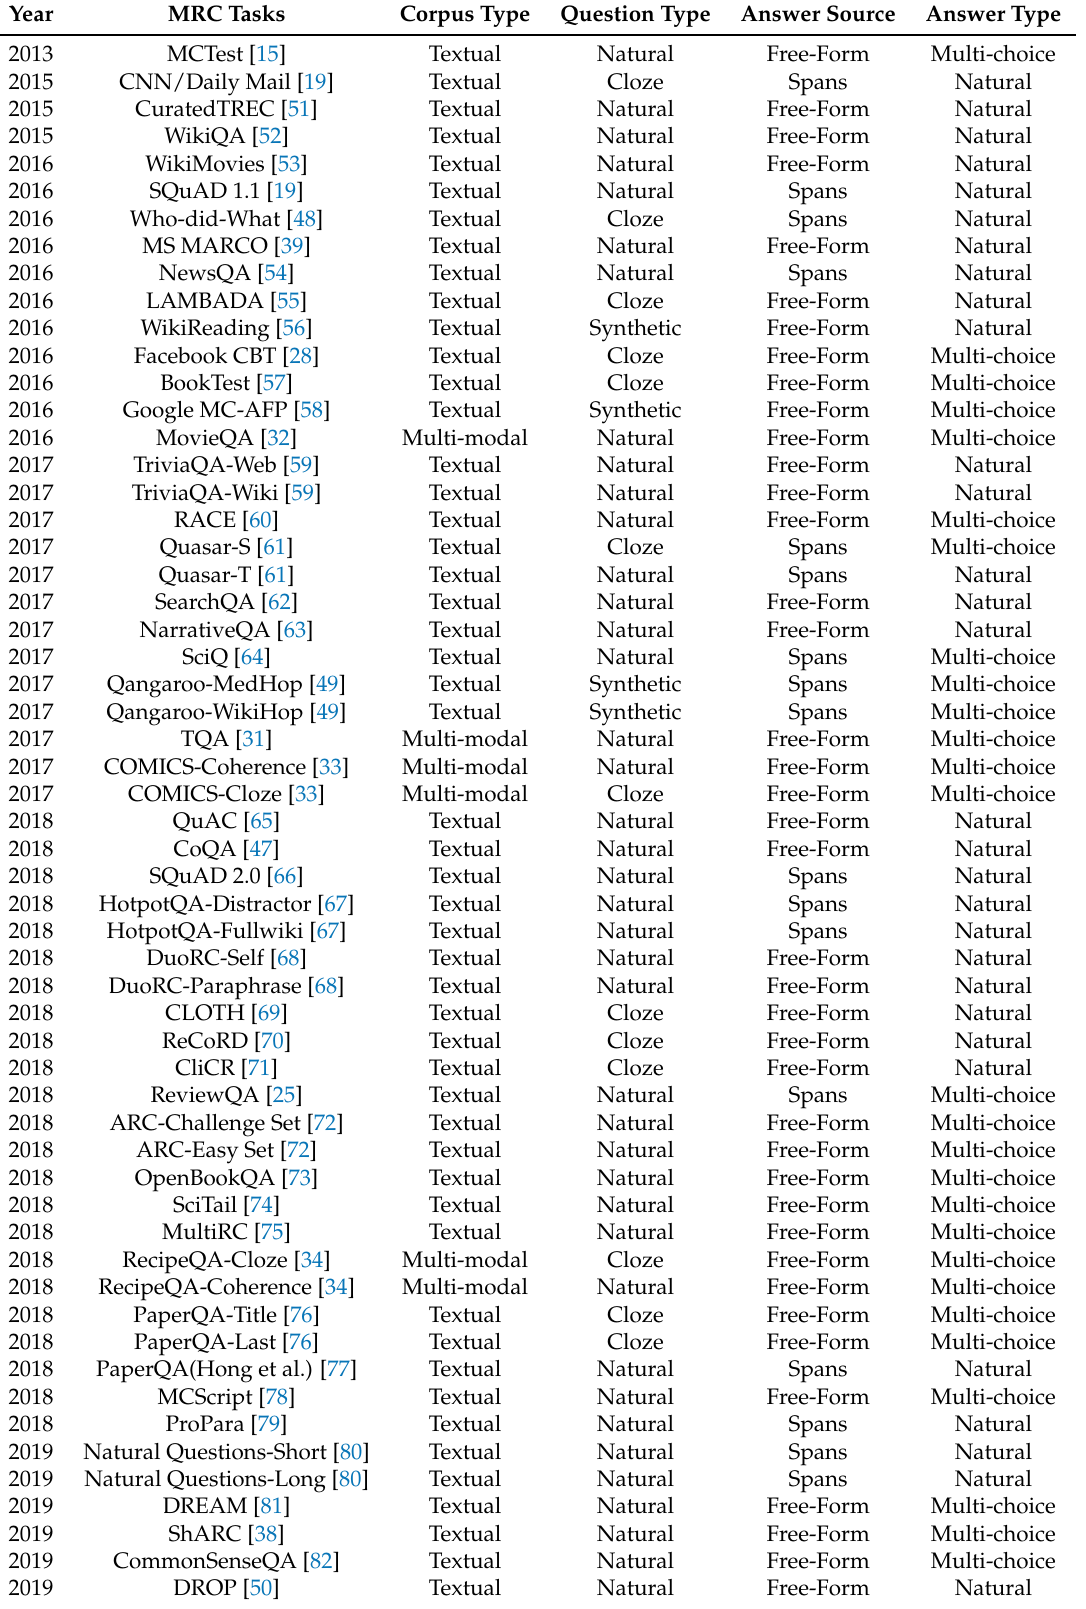
Table 1. Different machine reading comprehension